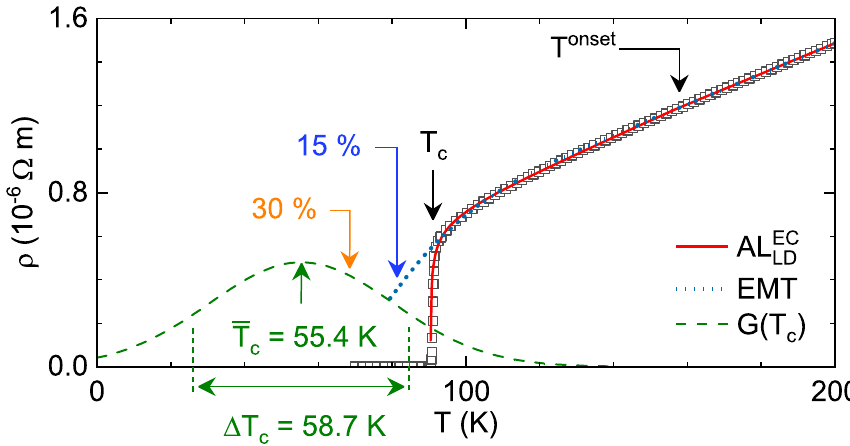
Fig. 3 Best fits of LD with total energy cutoff (solid red line) and EMT (dotted blue line) approaches to the in-plane resistivity 𝜌 ab ( T ) data. The EMT scenario fails to faithfully represent the transition both close and far from T c (see also Fig. 2). The curve represent- ing the distribution